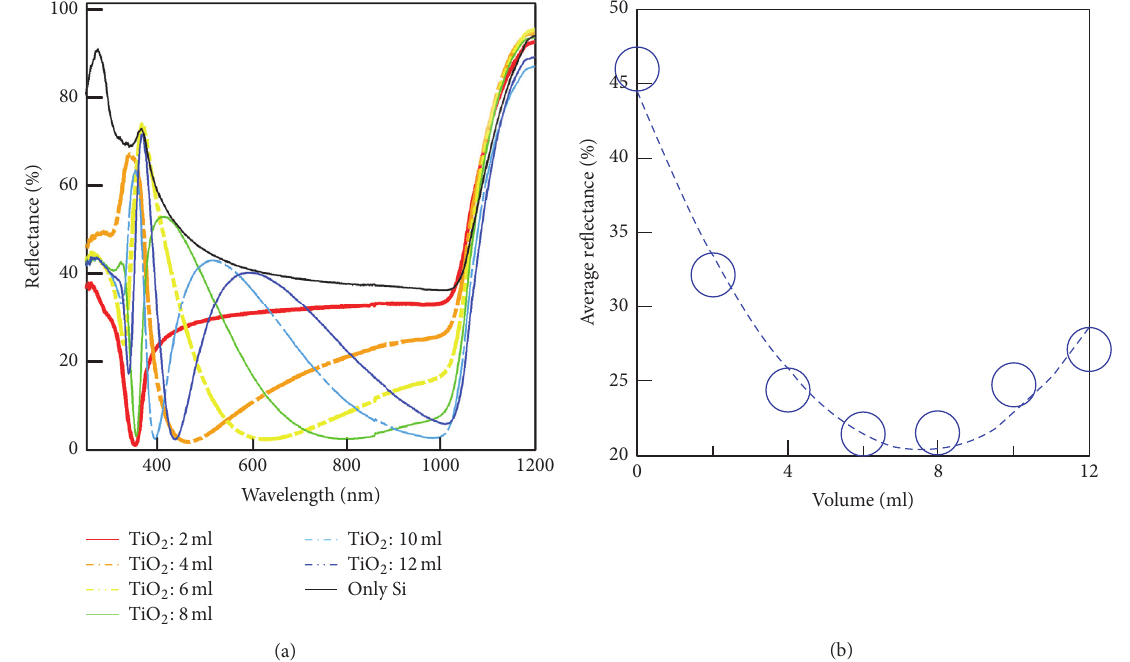
Figure 1: Comparison of the reflectivity of the flat samples with TiO 2 antireflection coatings by various amount TiO 2 precursor solution. (a) Reflectance spectra depending on spraying amount. (b) Average reflectance (300–1100nm wavelength) depending on spraying amount.